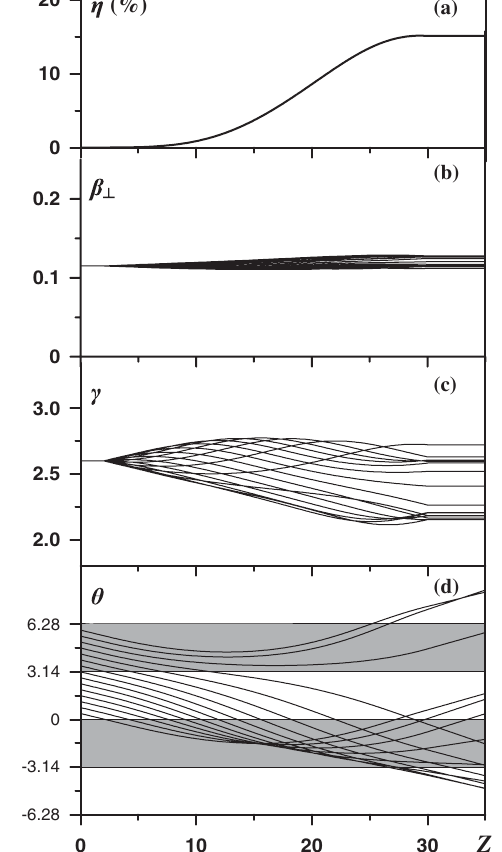
FIG. 6. FEL with a reversed guide field driven by ideal elec- tron beam. Dependence on longitudinal coordinate of (a) electron efficiency as well as (b) transverse velocity, (c) energy, and (d) phase with respect to the rf wave for electrons with different initial phases (the hatched zones represent decel- ¼ 2 : 6 , (cid:4) ¼ 0 : 5 , (cid:4) ¼ 0 : 15 , f ¼ (cid:2) 1 : 2 , erated phases): (cid:3) w s 0 ¼ 0 : 22 , g ¼ 6 : 5 , (cid:4) ¼ (cid:2) 0 : 16 (cid:9) 0